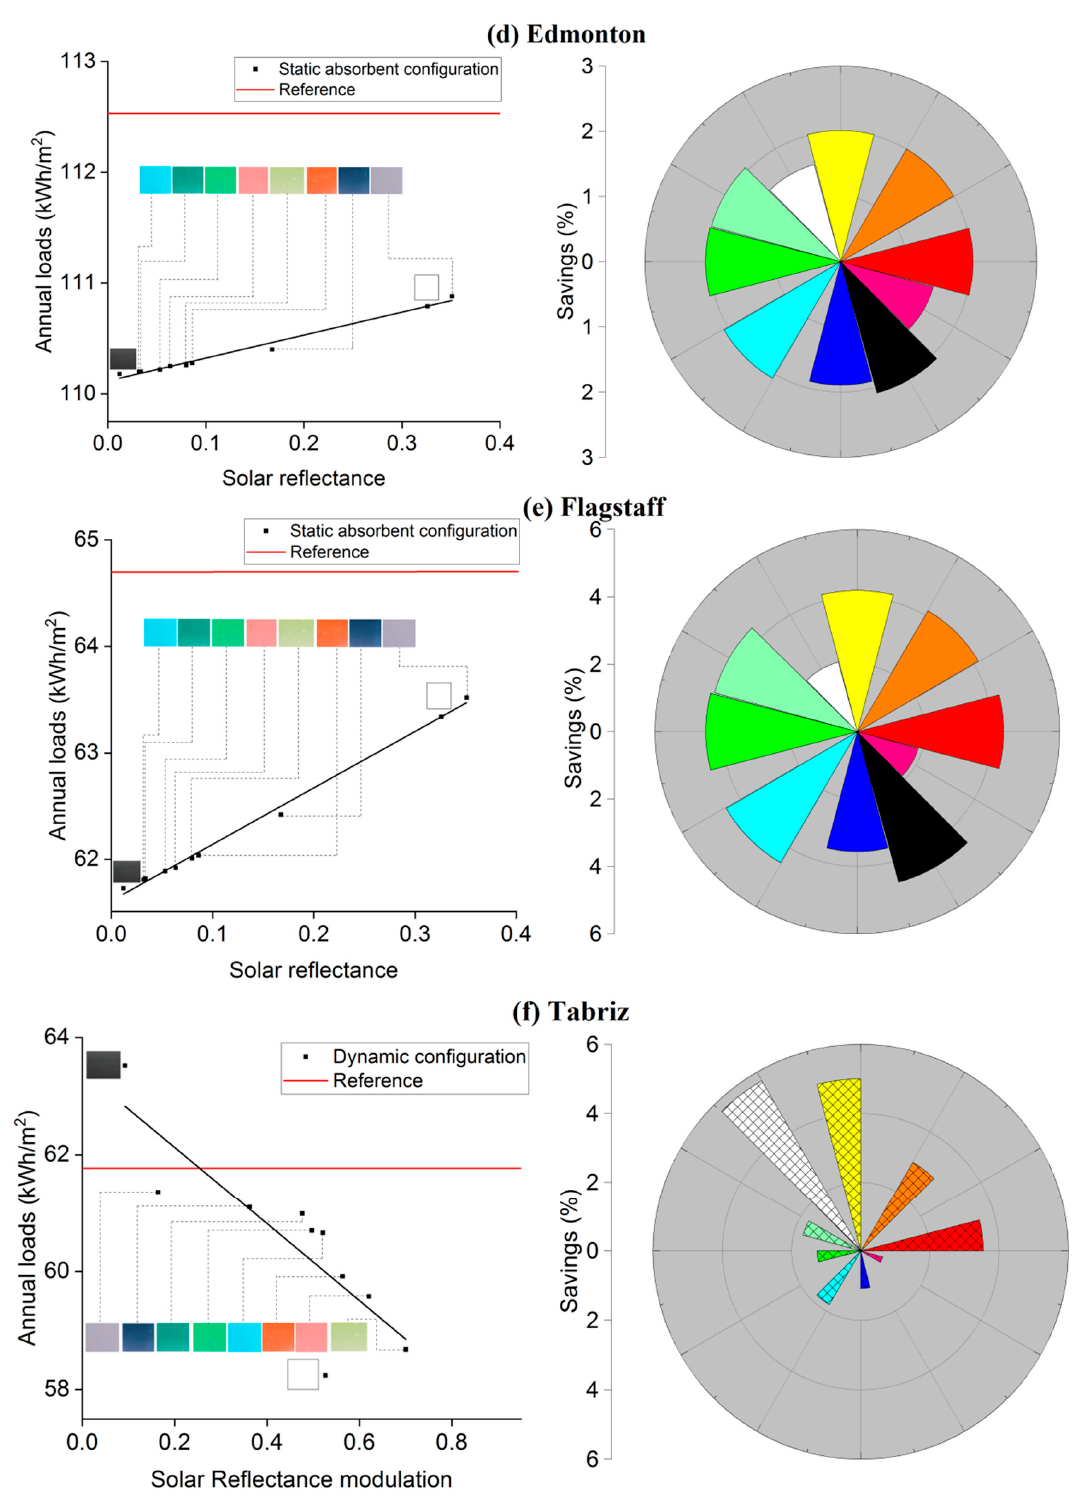
Figure 7. HVAC load savings in climate D (Cold): ( a ) New York, ( b ) Kiev, ( c ) Beijing, ( d ) Edmonton, ( e ) Flagstaff and ( f ) Tabriz. Right graphs: static configuration, solid color, dynamic configuration, striped color.